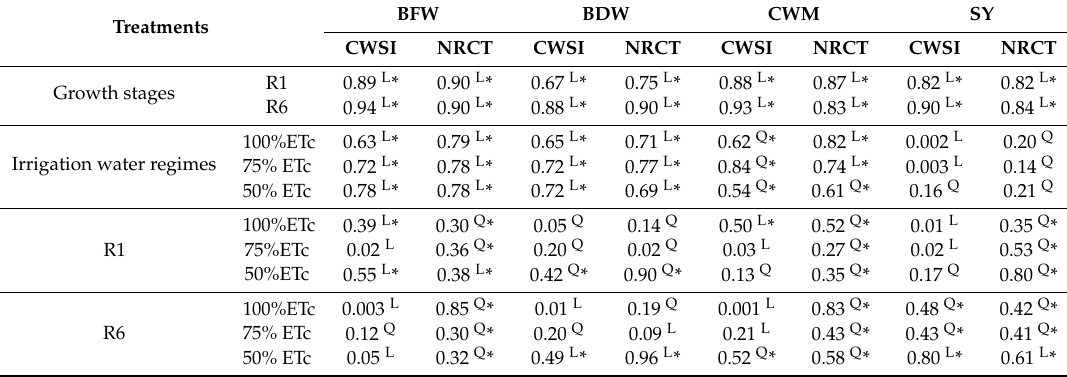
* Numbers indicate statistical significance at p ≤